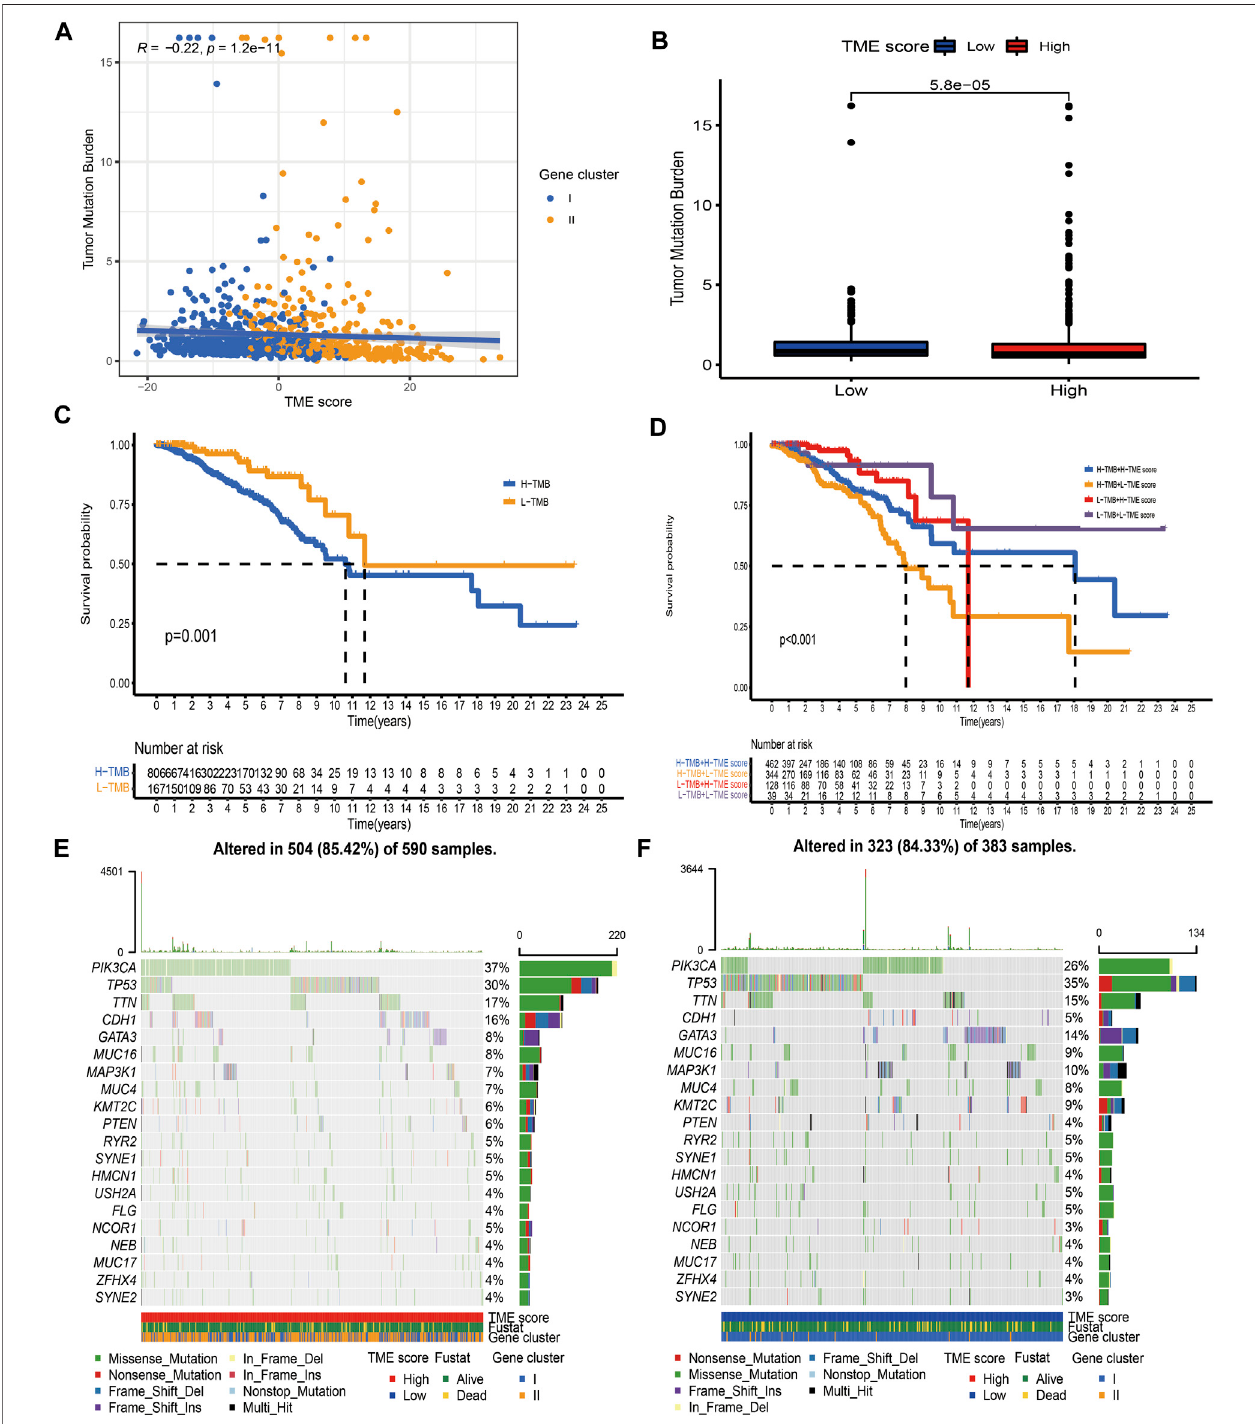
FIGURE7 | Characteristics ofthe TME-score intumor somatic mutation. (A) Correlationanalysis between TME-scoreand TMB. (B) Relative distribution ofTMB in high versuslowTME-scoregroups. (C) Kaplan – Meier curve for high and lowTMB patientgroups ( p = 0.001). (D) Kaplan – Meier curve for subgroup patients strati fi ed by both TME-score and TMB ( p < 0.001). (E, F) Mutational landscape of SMGs in the TCGA-BRCA dataset strati fi ed by high (left panel) versus low TME-score (right panel) groups. Individual patients were represented ineach column. The upper bar plot showed TMB, and theright bar plot showed themutation frequency ofeach gene in separate TME-score